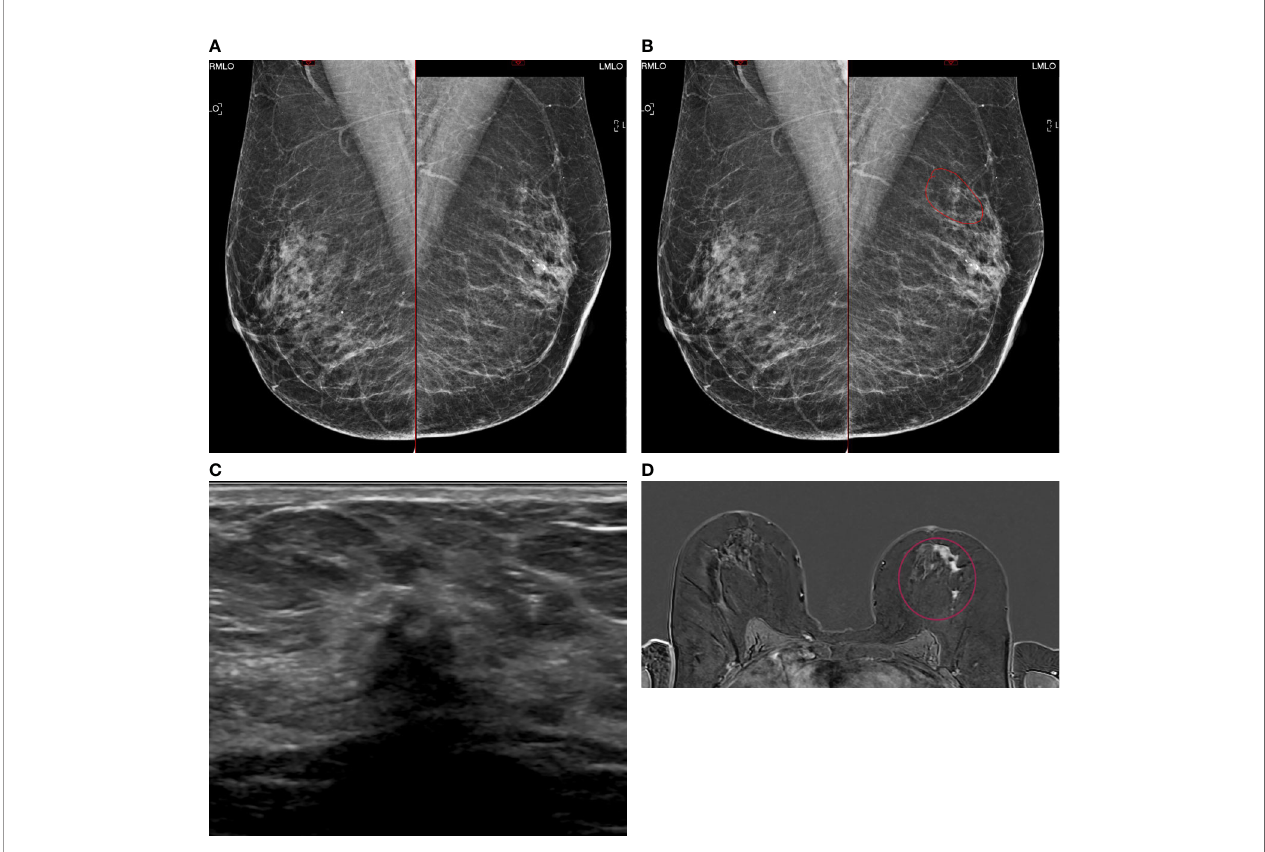
FIGURE 5 | A case of extensive ILC in a 50-year-old female attending for 1 st breast screening. (A) Mammogram: Right and left MLO views. (B) Mammogram is reported as M3. There is a 5-mm area of concern on the left which is circled. The calci fi cations are considered benign. The patient does not feel a palpable